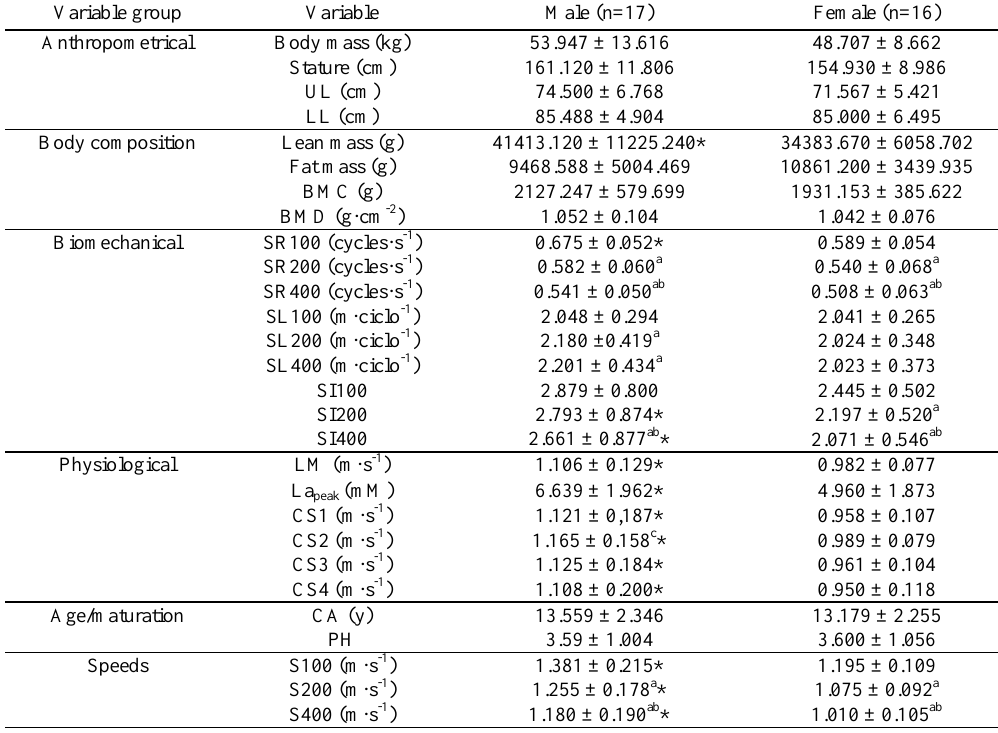
Table 1. Mean ± Standard Deviation (SD) of independent variable groups: anthropometrical, body composition, biomechanical, physiological and age/ maturation; and speeds as dependent variables for male and female swimmers.